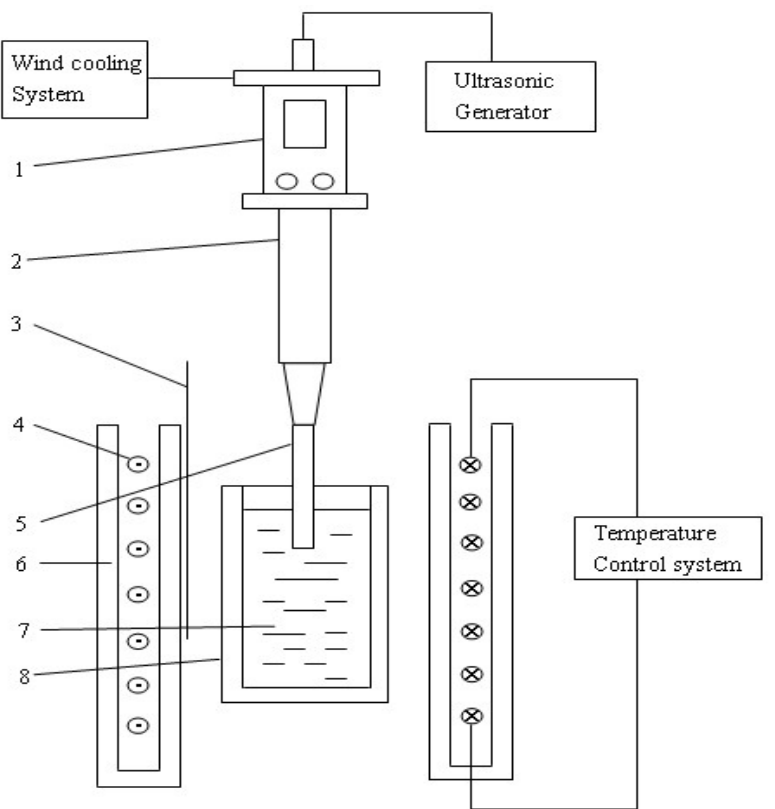
Figure 1. Schematic diagram of the ultrasonic treatment experimental set-up. 1—Ultrasonic trans- ducer; 2—Cone; 3—Thermocouple; 4—Resistance heater; 5—Ultrasonic radiator; 6—Ceramic tube; 7—Magnesium alloy melt; 8—Iron crucible.